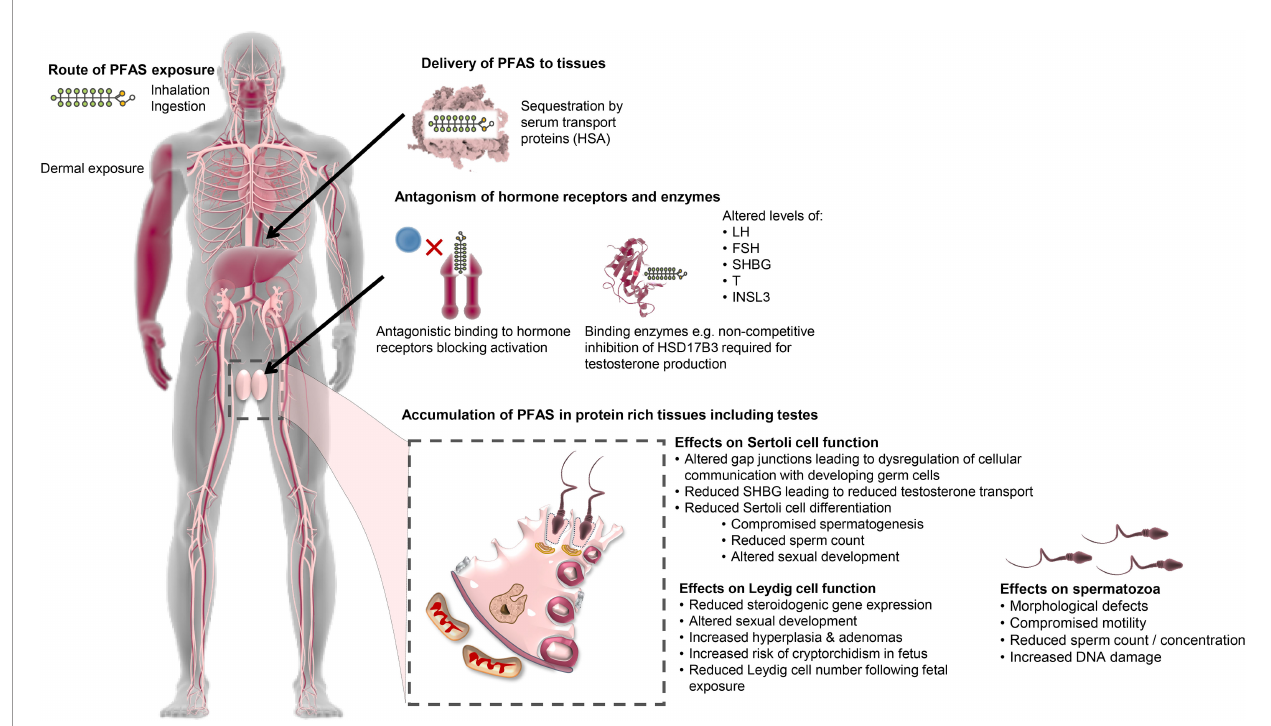
FIGURE 3 | Proposed mechanisms of PFAS action pertaining to the male reproductive system. PFAS have the potential to enter the body through multiple routes. Following entry, PFAS are capable of binding to fatty acid binding proteins and transport proteins in the blood such as human serum albumin (HSA) and thereafter are thought to be transported throughout the body eliciting harmful endocrine effects via two possible mechanisms: disturbing steroidogenesis (e.g. via allosteric inhibition of vital enzymes) or directly interfering with steroid hormone receptors. This results in altered levels of reproductive hormones such as luteinizing hormone (LH), follicle stimulating hormone (FSH), sex hormone binding globulin (SHBG), testosterone (T) and insulin-like peptide 3 (INSL3), which has subsequent effects on male reproductive processes. PFAS also accumulate in protein rich tissues, including the testes, which is facilitated by the high expression of fatty acid binding proteins. Here, PFAS impact testicular cell function, namely Leydig and Sertoli cells. Altered Leydig cell function leads to reduced testosterone production resulting in altered sexual development, increased incidence of hyperplasia and adenomas and increased risk of cryptorchidism in the fetus. This reduction in testosterone leads to attendant impacts on Sertoli cell function by reducing Sertoli cell differentiation and precipitating compromise of spermatogenesis, reduced sperm count and altered sexual development. Gap junctions between Sertoli cells and developing germ cells are also affected by PFAS, which reduces communication between the cells, negatively affecting spermatogenesis and resulting in a range of defects in the mature